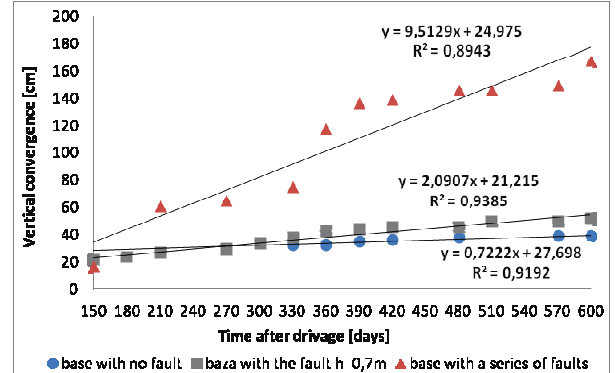
Fig. 7. Vertical convergence for the measurement